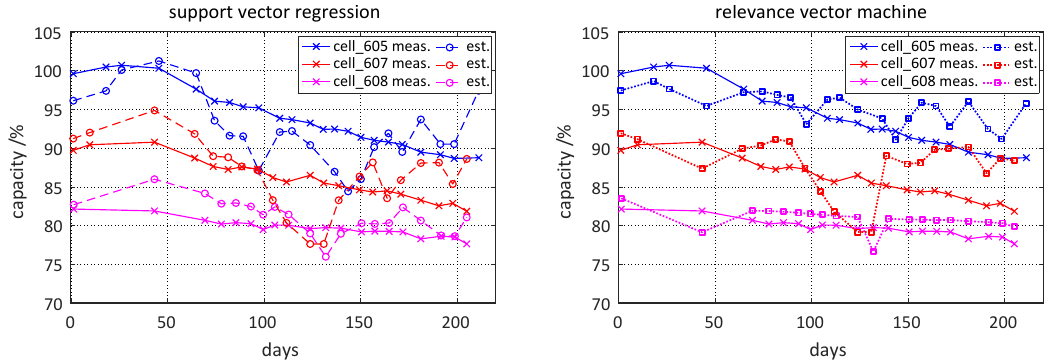
Figure 11. Results from a SVR and RVM initial batch model from Figure 9 without an incremental update enhancement on data from vehicle durability